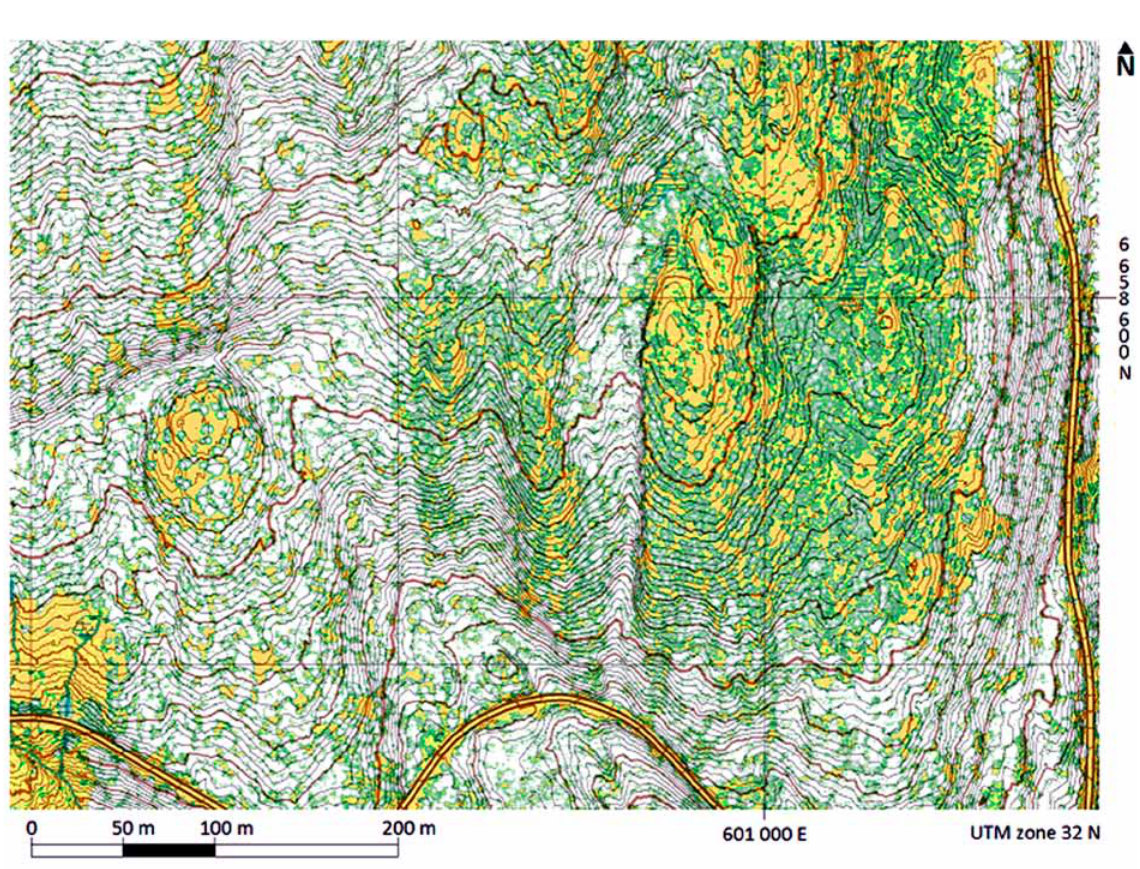
Fig. 1. Base map for field survey at Tømte. Vegetation height is color-coded (yellow-green-white; see Table 3). Grey lines = elevation contour lines with 1 m height interval and no smoothing. Thin and thick brown lines are index contour lines at 5 m and 25 m height intervals, respectively. The parallel grey lines with yellow in the middle are